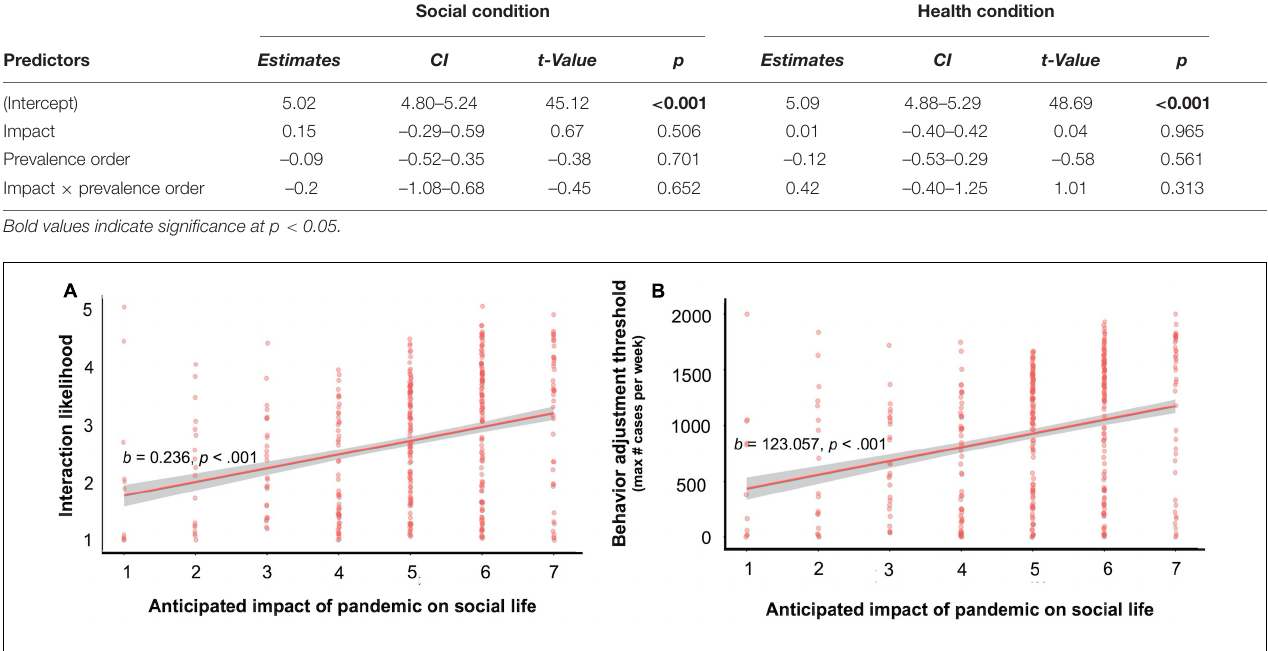
FIGURE 4 | The relation between perceived social impact and intentional social interactions in hypothetical situations. (A) Participants’ self-reported likelihood of interaction (averaged across 10 imagined social scenarios). (B) The maximum number of new positive COVID-19 cases per week (in an imagined city of 500,000 residents) at which the participants self-reported remaining willing to visit various locations outside the home (averaged across six locations). Error bars represent standard error of the